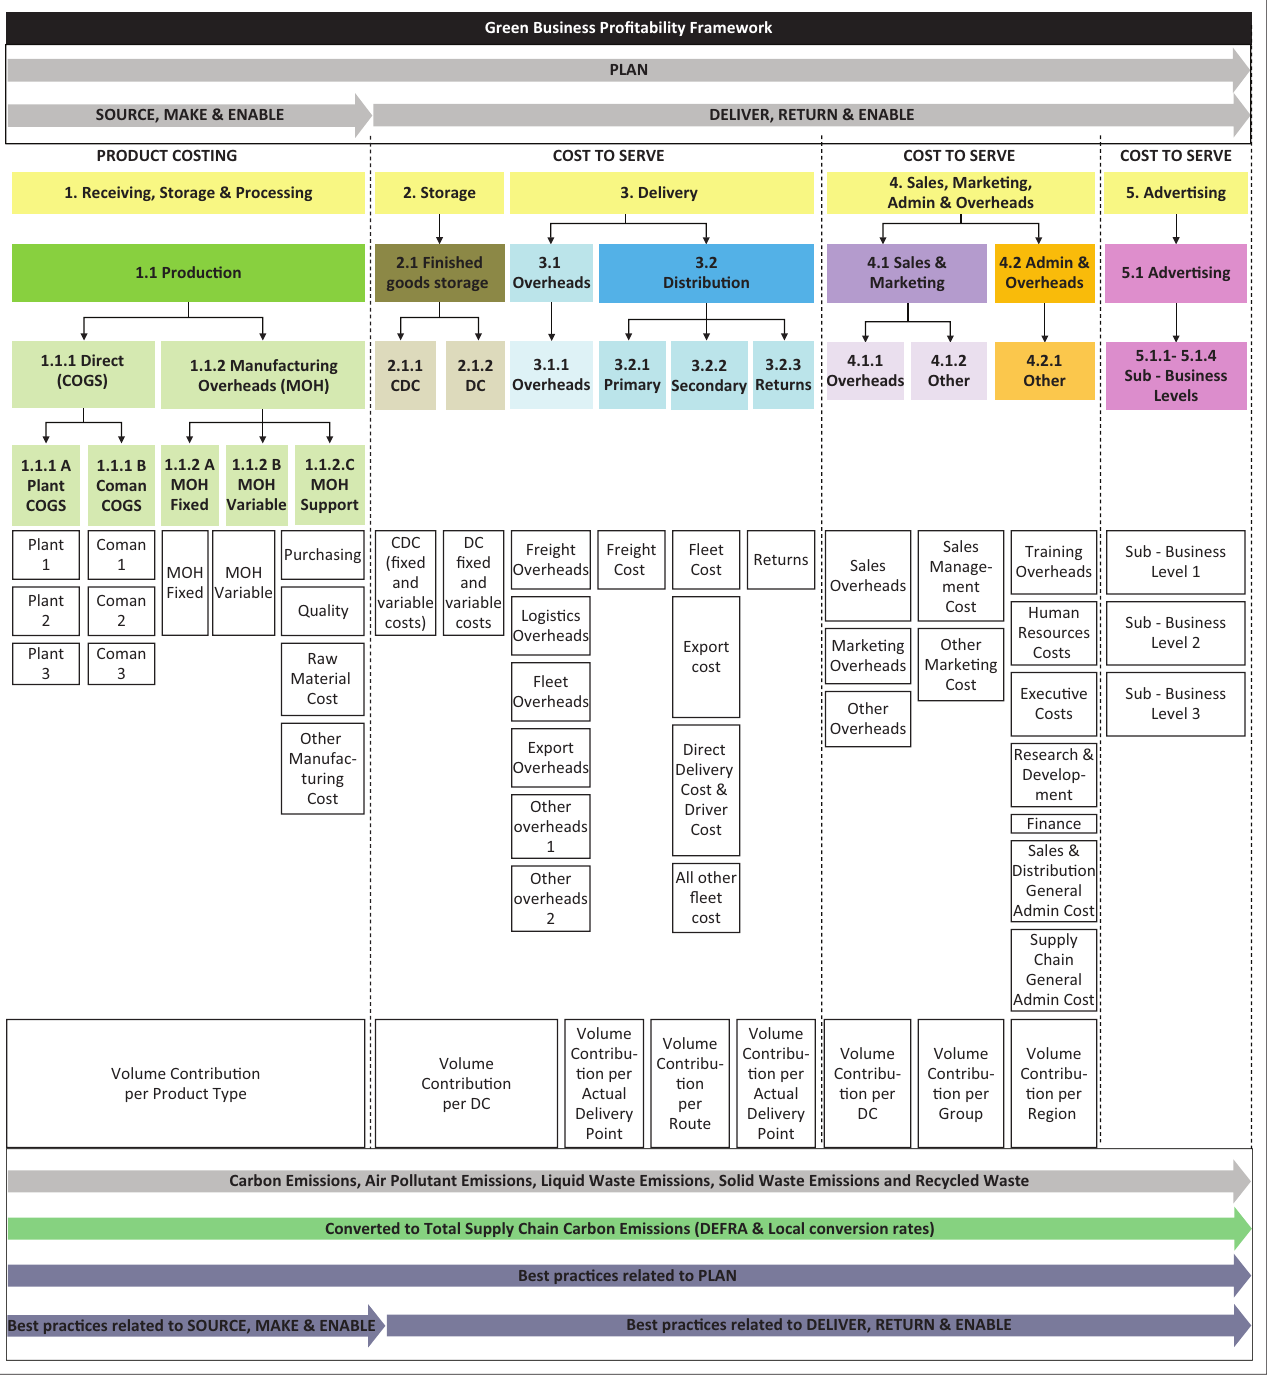
FIGURE 1: Developed Green Business Profitability